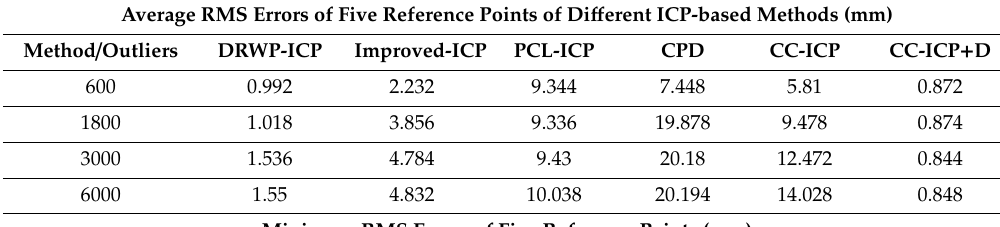
Table 12. The Average, Minimum and Maximum of Reference Points’ Alignment Errors.